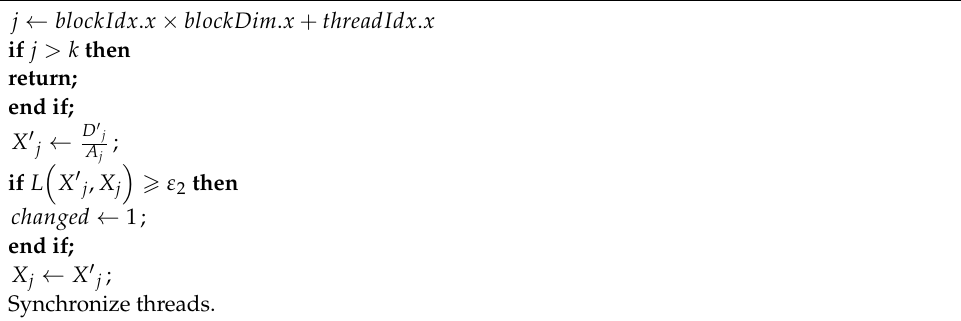
Algorithm 6 CUDA implementation of Step 2 in the ALA